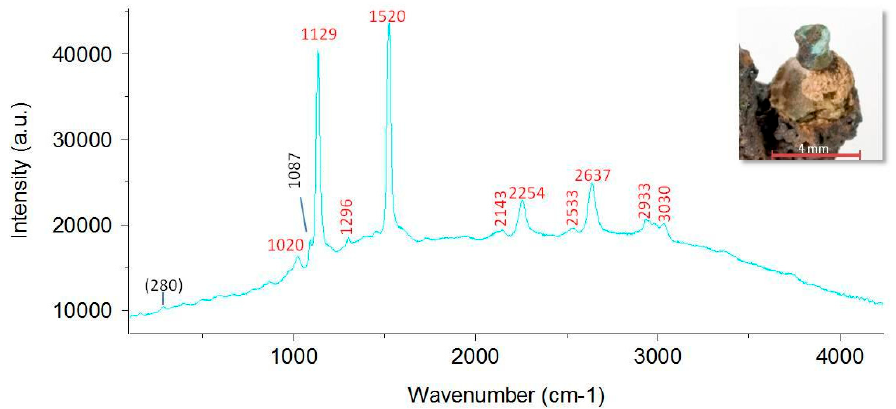
Figure 6. Ilvesheim “Weingärten”; Raman spectrum of foot bead of small iron fibula. The characteristic ν 1 and ν 2 frequencies of the pigments at 1520 and 1129 cm − 1 are still very intense. Red = pigments; black = calcite.